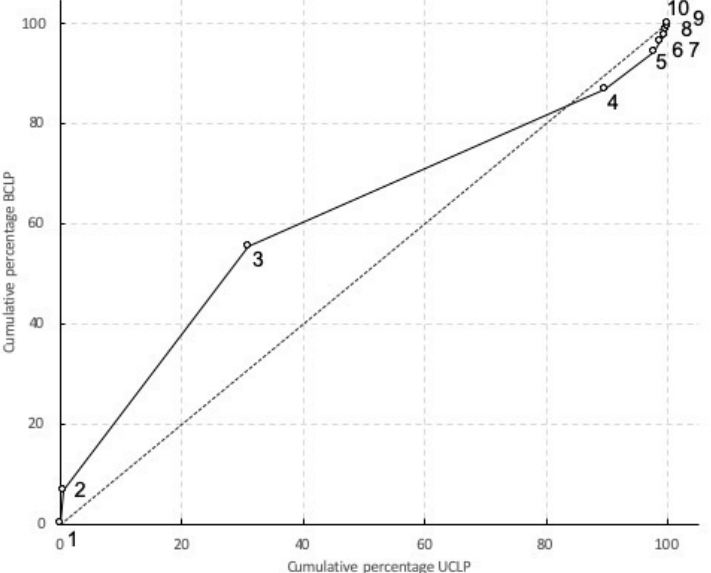
Figure 2. The cumulative percentage of the ten material property groups for the unilateral cleft lip and palate (UCLP) and bilateral cleft lip and palate (BCLP) models, respectively. The material properties of the ten different bone types are retrieved from Nalabothu et al. [44].